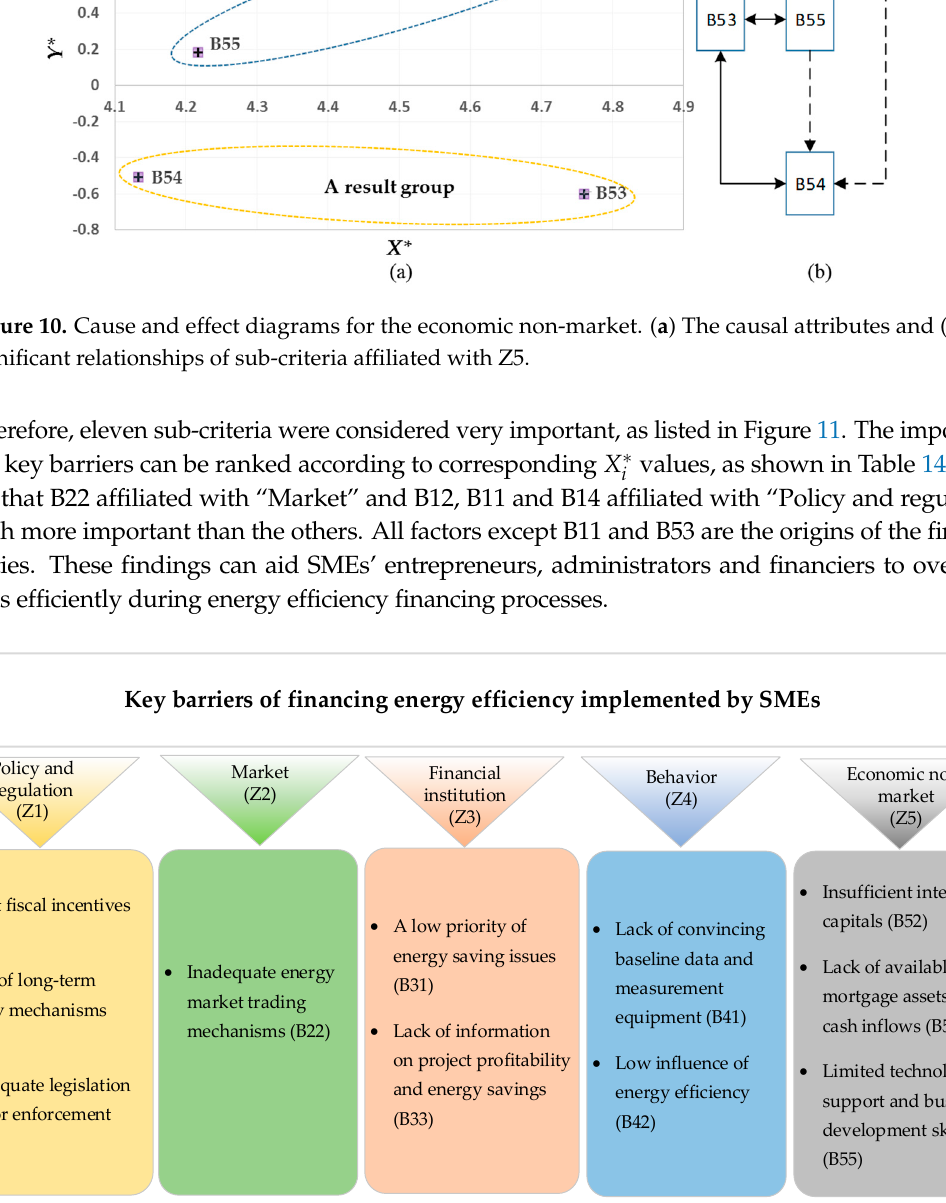
Figure 9. Cause and effect diagrams for the behavior. ( a ) The causal characteristics of corresponding sub-criteria and ( b ) obvious cause and effect relations.